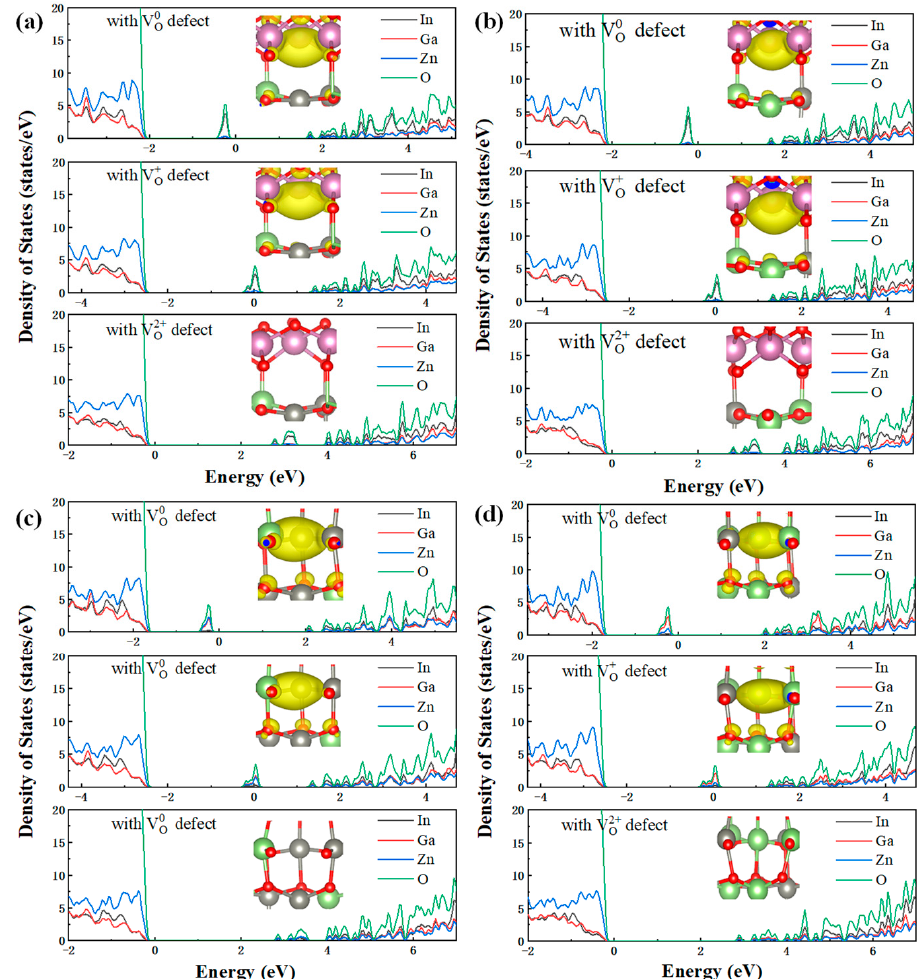
Figure 8. DOS of oxygen vacancy ( a ) V O1 , ( b ) V O2 , ( c ) V O3 and ( d ) V O4 with different charge states in CAAC-IGZO active layer.